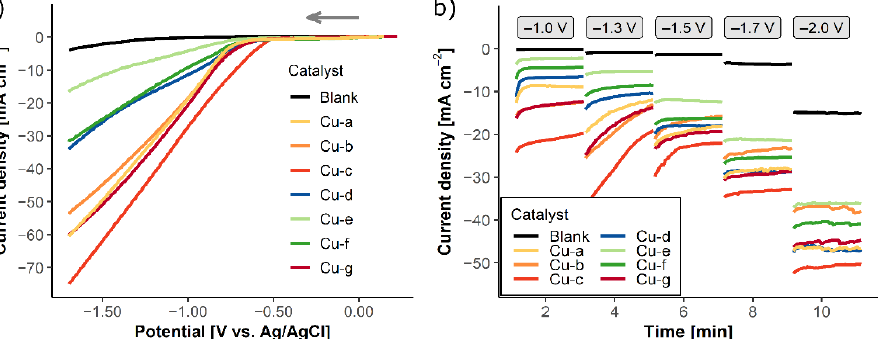
Figure 3. ( a ) LSV and ( b ) CA measurements of the synthesized copper catalysts in CO 2 -saturated 0.5 M KHCO 3 , blank = carbon paper without catalyst. LSV was measured from open circuit poten- tial (OCP) to − 1.7 V vs . Ag/AgCl. CA measurements were performed at the different step poten- tials − 1.0, − 1.3, − 1.5, − 1.7, and − 2.0 V vs. Ag/AgCl for 2 min